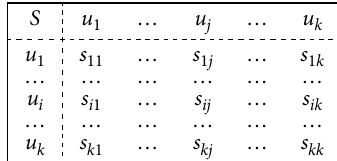
Table 3. Average consistency values of random matrices